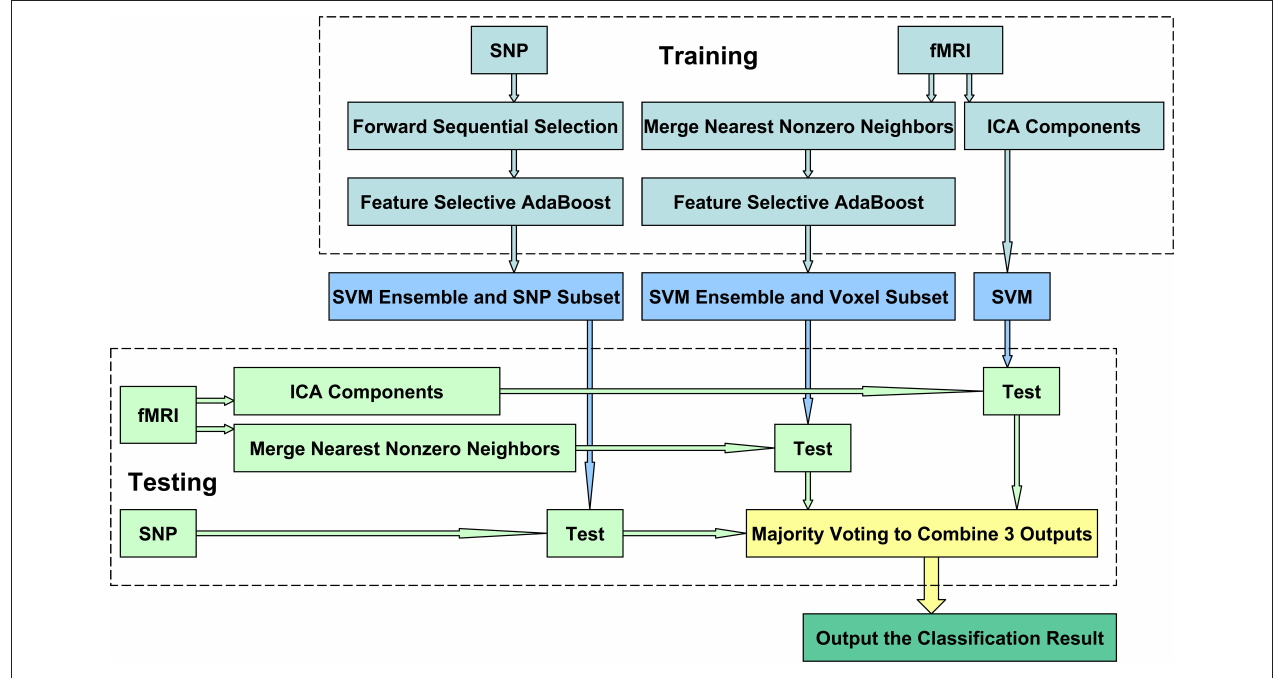
Figure 1 | Flow chart of